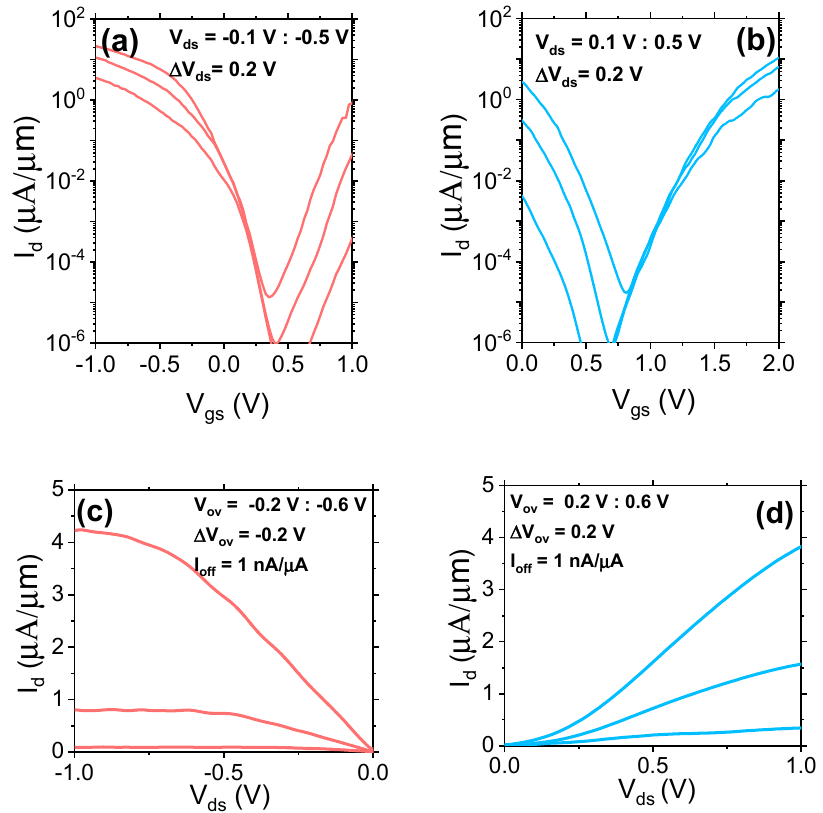
Figure 4. Measurement results of Set 2 devices: transfer characteristics I d -V g for p-TFET ( a ), and n-TFET ( b ); Output characteristics I d -V ds for the corresponding devices ( c , d ). The p-TFET device shows a linear onset, indicating higher concentration of the n + /channel junction.